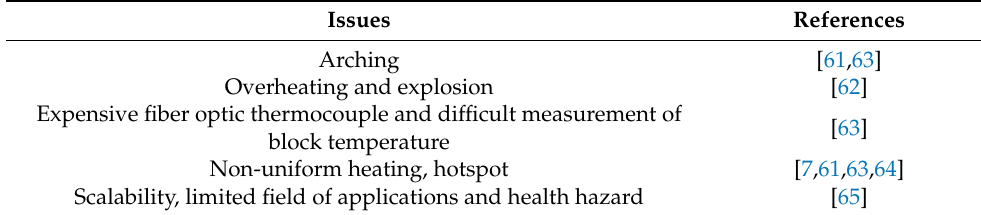
Table 3. Limitations of stand-alone microwave